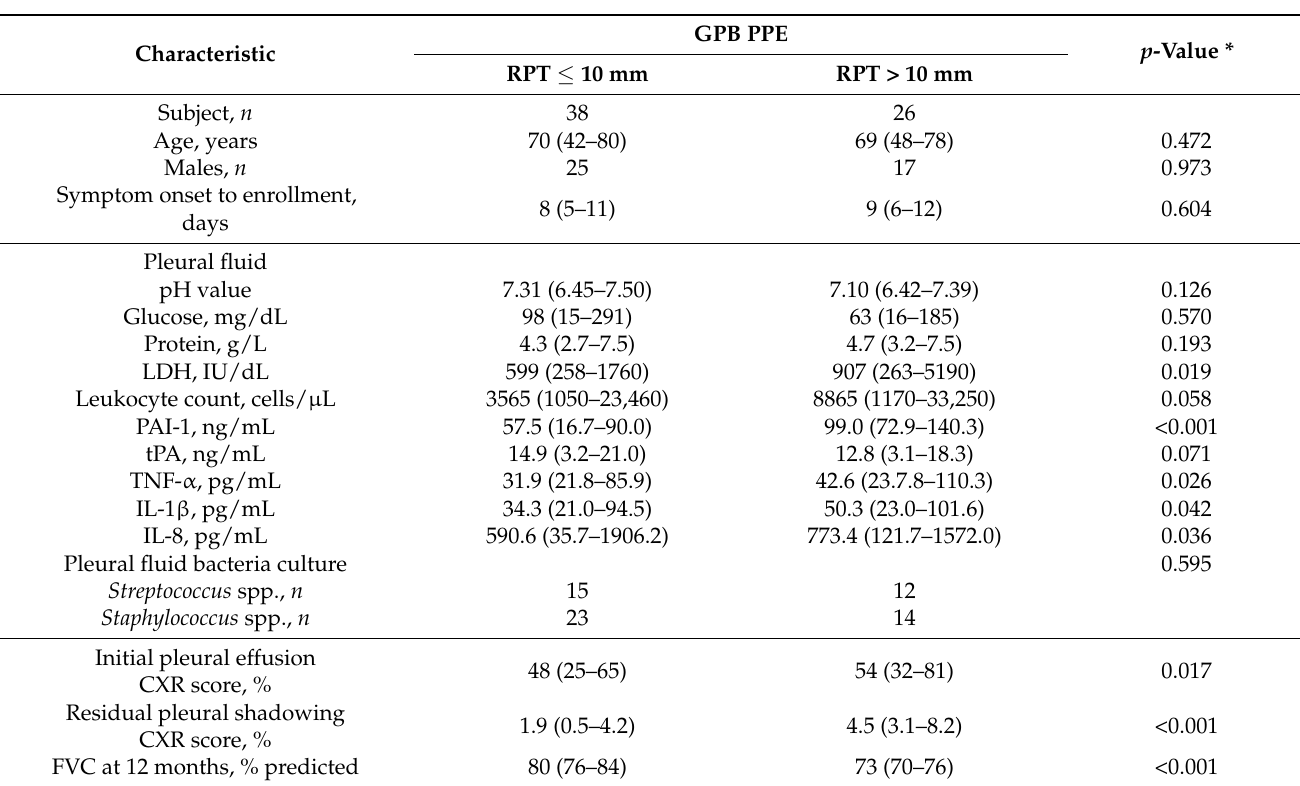
Table 1. Clinical and pleural effusion characteristics, and levels of fibrinolytic factors and cytokines in pleural fluid among all patients ( n = 64) † .